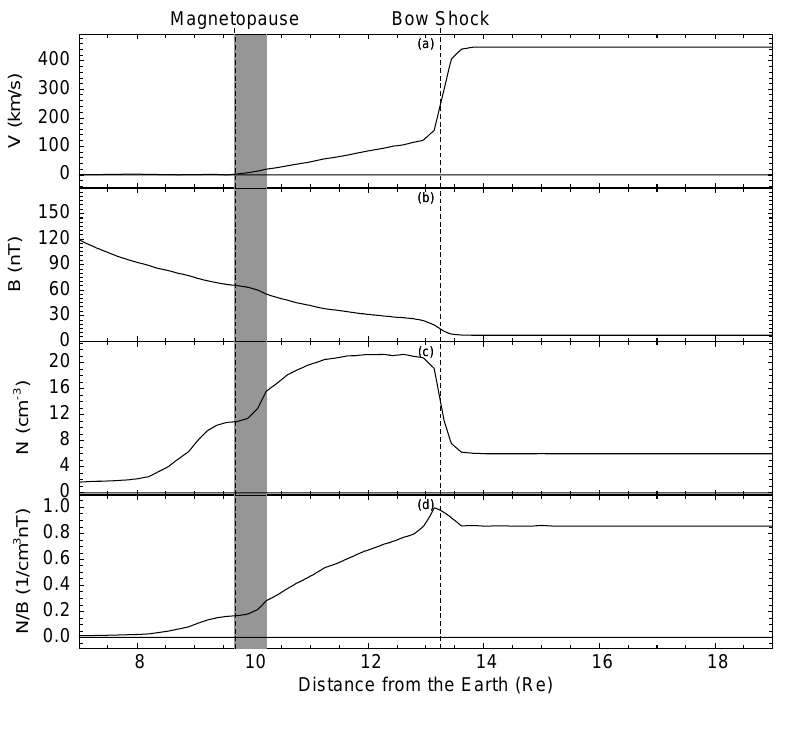
Fig. 2. Some parameters along the Sun- Earth line in Fig. 1. The four pan- els, from top to bottom, show the flow speed, the magnetic field magnitude, the plasma density, and the N/B ratio. The magnetopause is defined as the lo- cation where the magnetosheath flow speed is close to zero. The shaded re- gion marks the PDL and the dashed line marks the bow